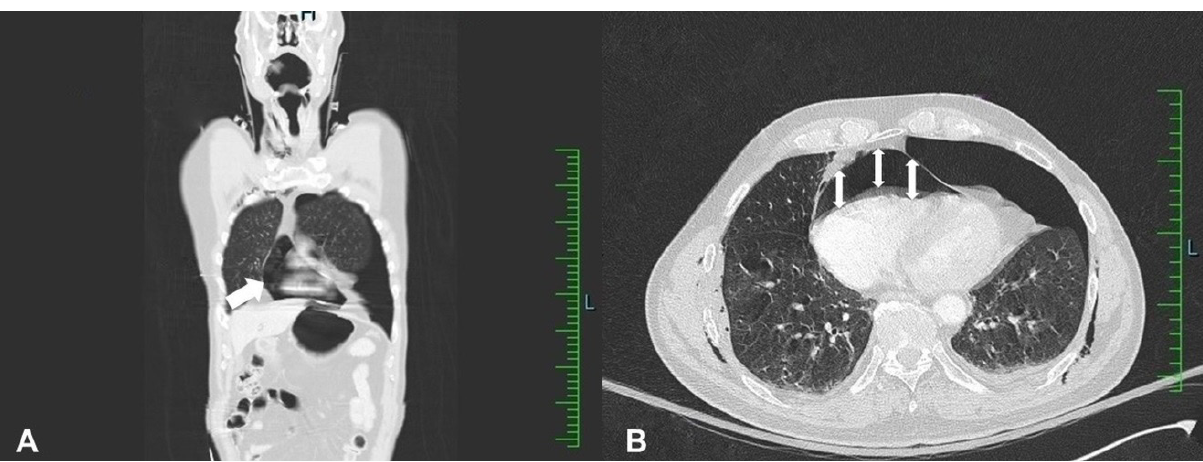
Fig. 1. CT scans showing air collection in the pericardial